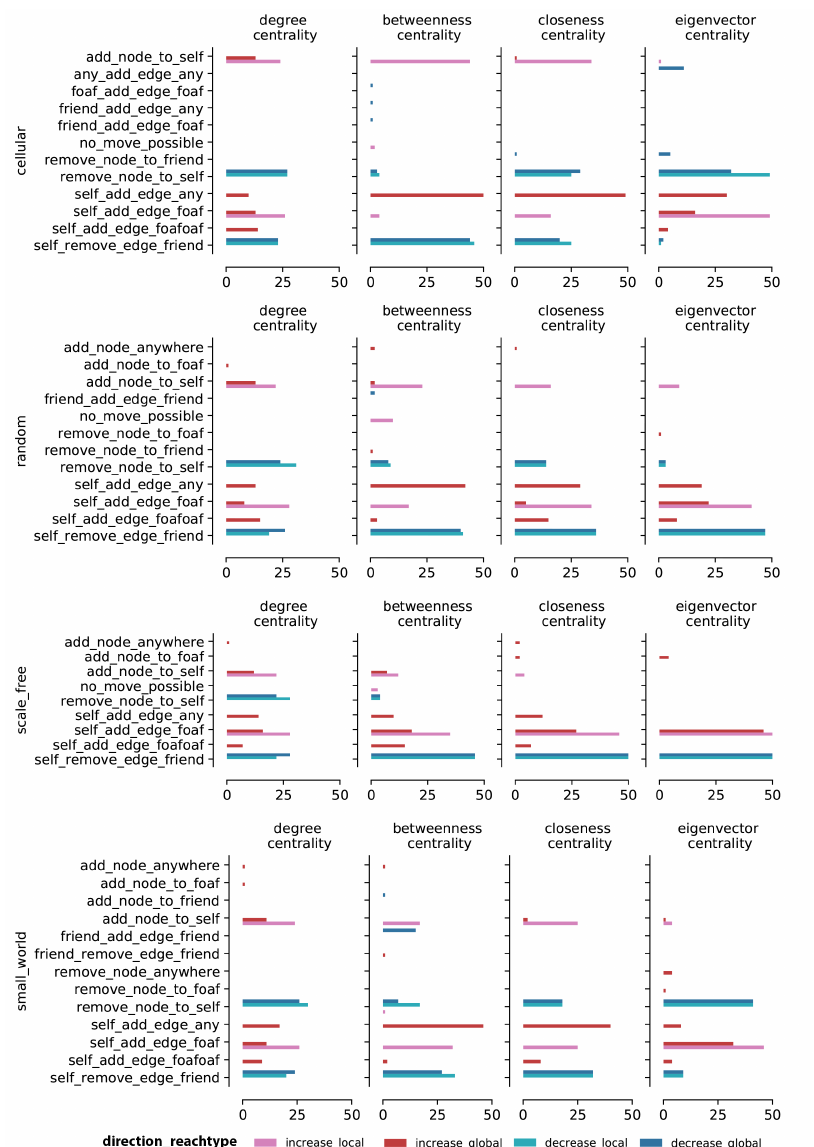
Figure 4. Optimal move counts per centrality measure and topology for small synthetic networks. The graph shows the frequency counts aggregated across 50 experiments for the optimal moves for small (20 nodes) synthetic networks across different centrality measures and network topologies. The x -axis shows the frequency counts for the optimal moves and the y -axis shows the different optimal